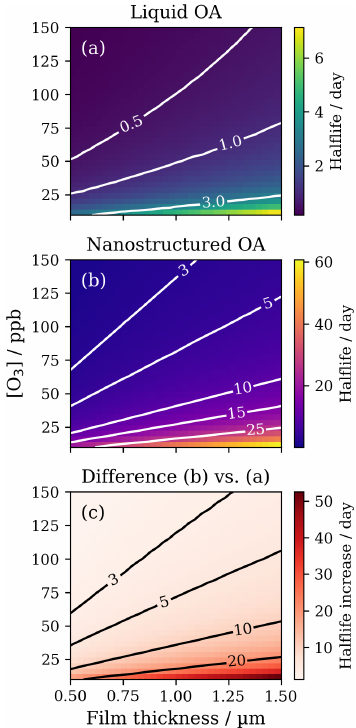
Figure 7. Plots of film half-life as a function of ozone concen- tration ( [ O 3 ] ) and film thickness. (a) Model runs using parame- ters for liquid oleic acid ( D Y, liq = 1 . 53 × 10 − 9 cm 2 s − 1 , D X, liq = 1 . 00 × 10 − 5 cm 2 s − 1 ); (b) model runs using the optimised parame- ters for lamellar-phase (nanostructured) oleic acid ( D Y, lam = 2 . 81 × 10 − 12 cm 2 s − 1 , D X, lam = 3 . 35 × 10 − 12 cm 2 s − 1 ); (c) resulting in- crease in half-life due to nanostructure formation. Contours in each plot represent lines of constant